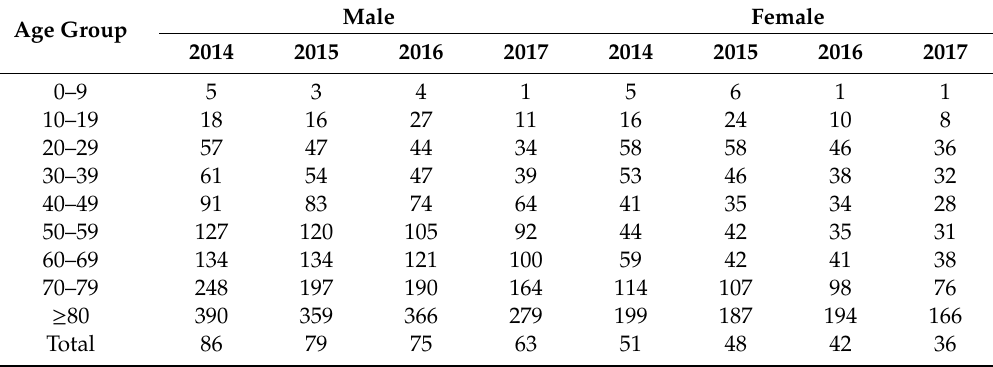
Table 3. Disability-adjusted life years due to tuberculosis per 100,000 population in Korea by sex and age, 2014–2017.